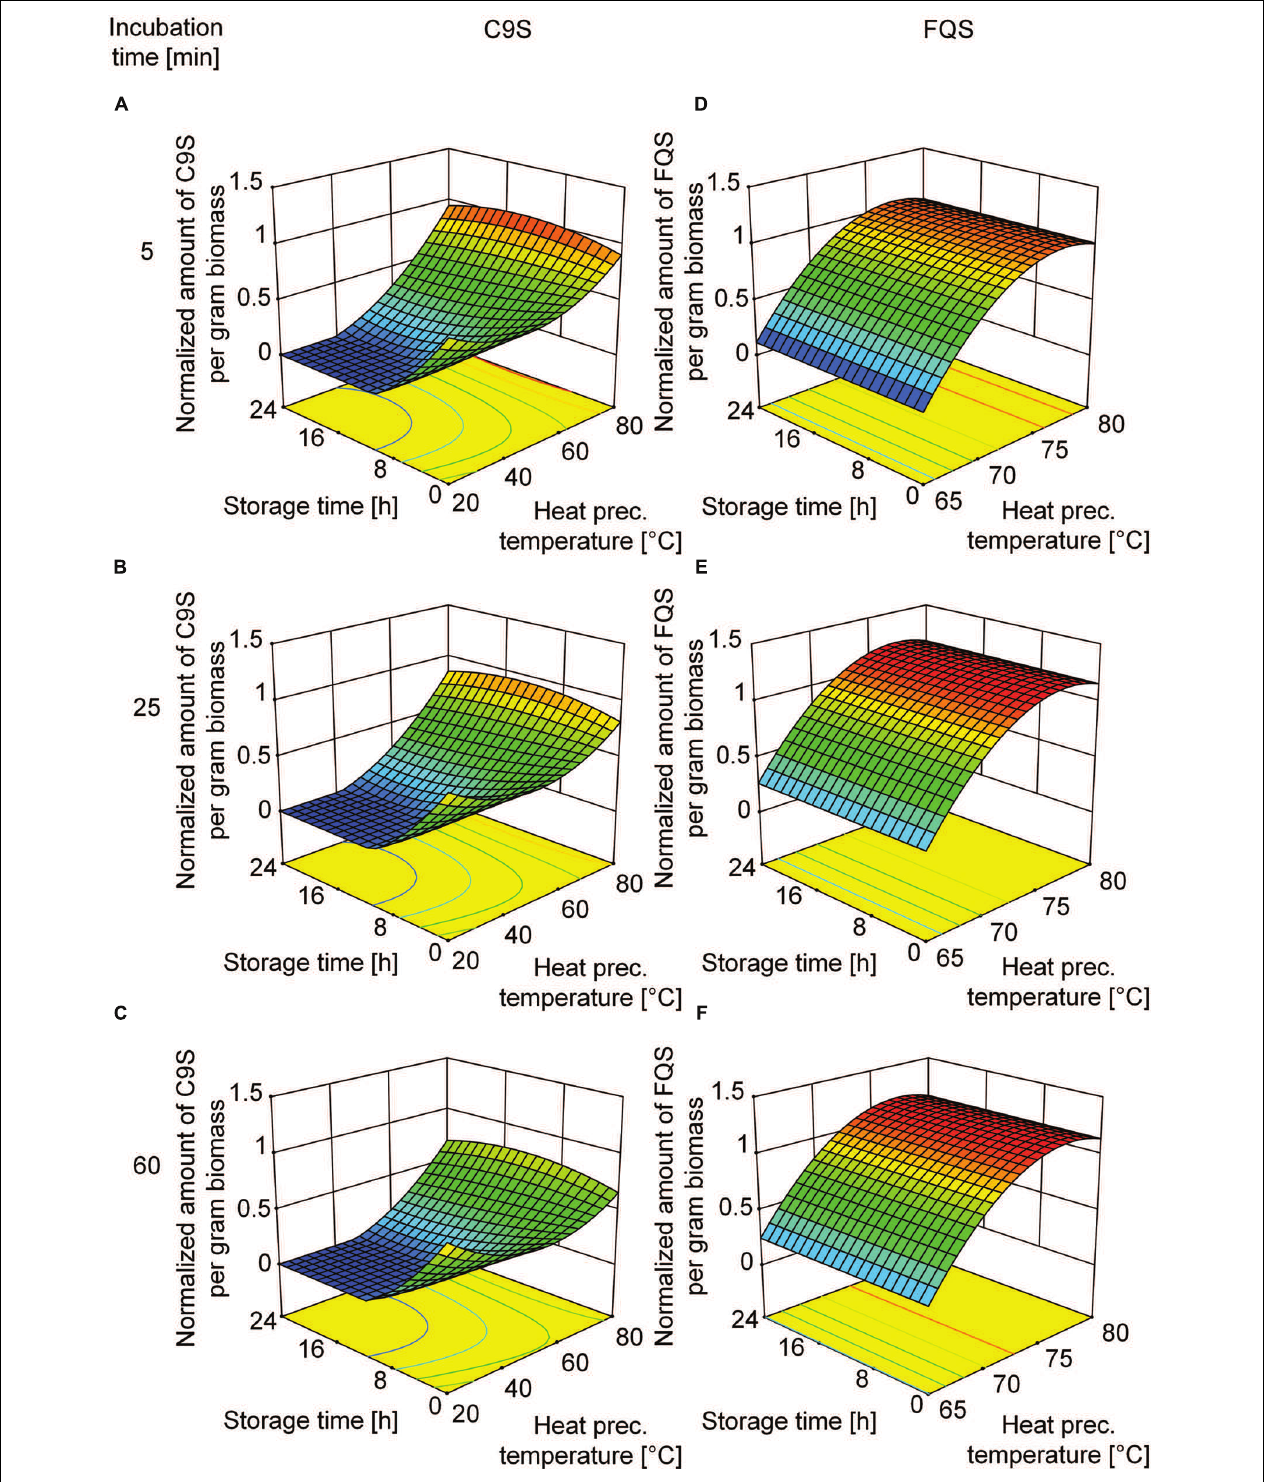
FIGURE 5 | Response surface representations of predictive models for C9S and FQS yields after the heat treatment of plant extracts, showing dependence on incubation temperature as well as incubation and storage durations. The yields of C9S (A–C) decreased if the heat treatment temperature fell below 65 ◦ C and losses increased with longer incubation and storage times. The yields of FQS (D–F) decreased if the heat treatment temperature fell below 72 ◦ C but neither incubation nor storage time had a relevant effect. C9S and FQS yields were normalized to a reference condition based on blanching at 80 ◦ C for 5 min and subsequent storage for 0 h. Colors are used to indicate high (red) or low (blue) response values.